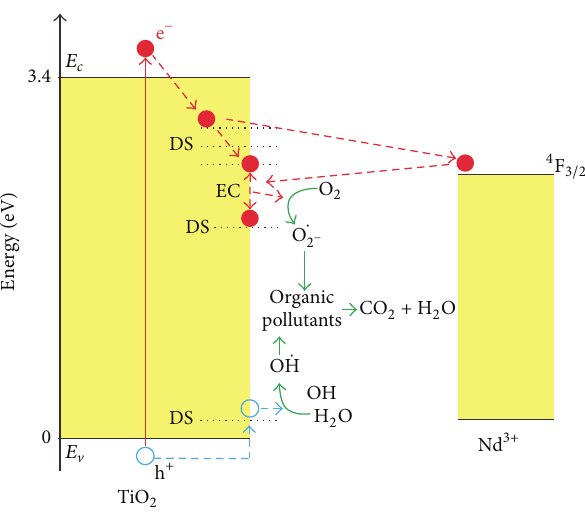
Figure 1: Schematic representation of photo-induced decomposi- tion of organic pollutants with TiO 2 :Nd. Designations: EC: electron capturing, DS: defect states, e − : electron, h + : hole, 𝐸 𝑐 : conduction band, and 𝐸 V : valence band.